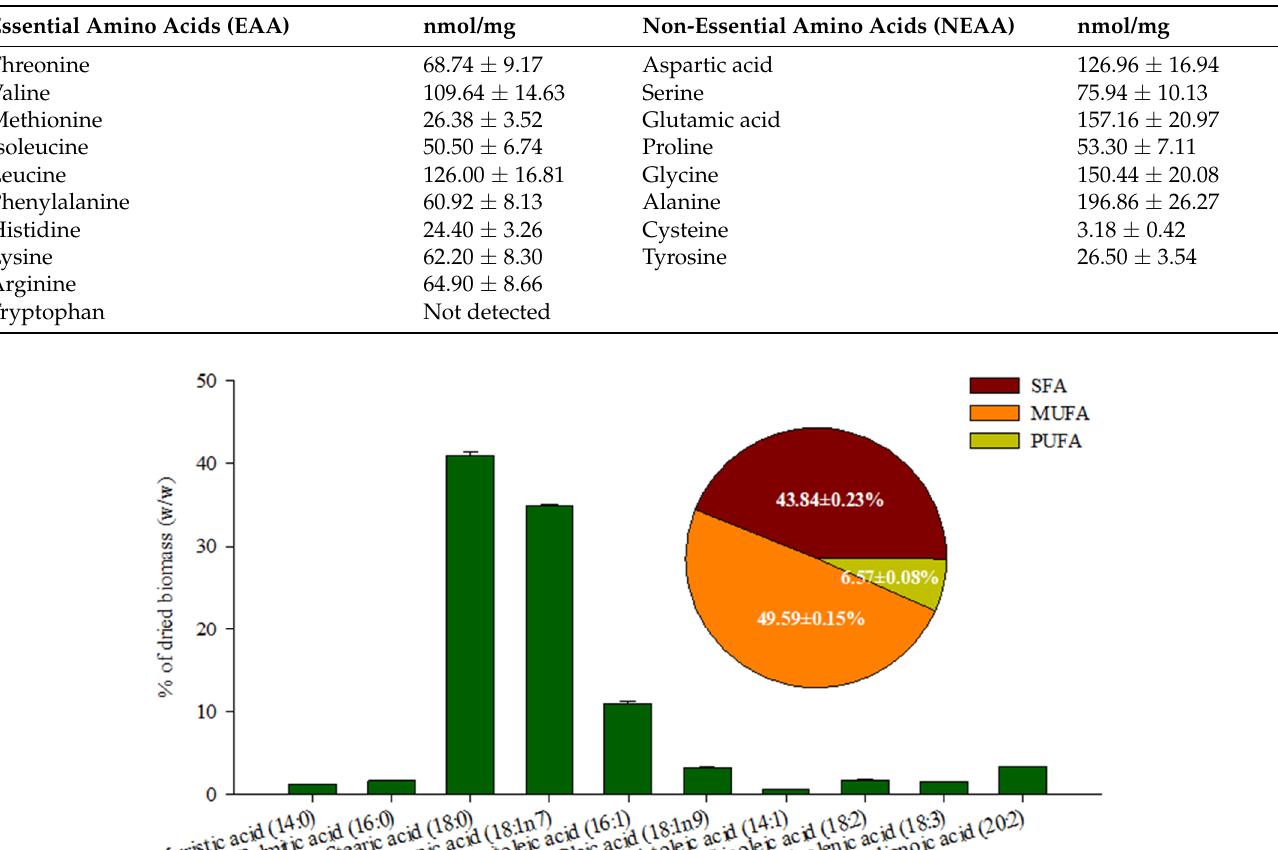
Table 1. Amino acid profile of Coelastrella sp. KKU-P1 biomass.